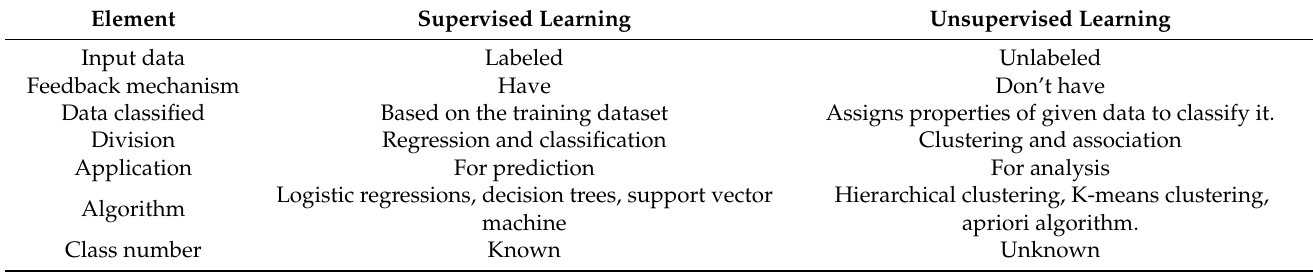
Table 2. Basic differentiation between supervised and unsupervised learning.